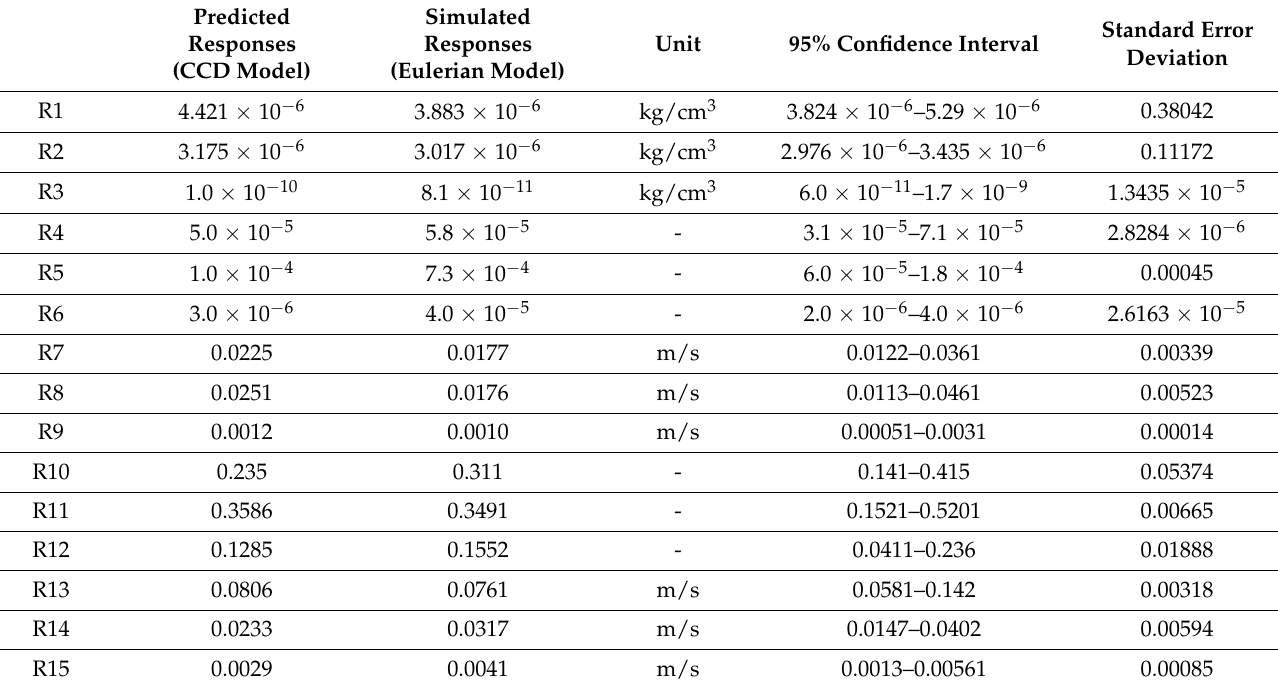
Table 5. Results of validation tests for CCD design and optimizer